Question: Which kind of chart has been used to present this data?
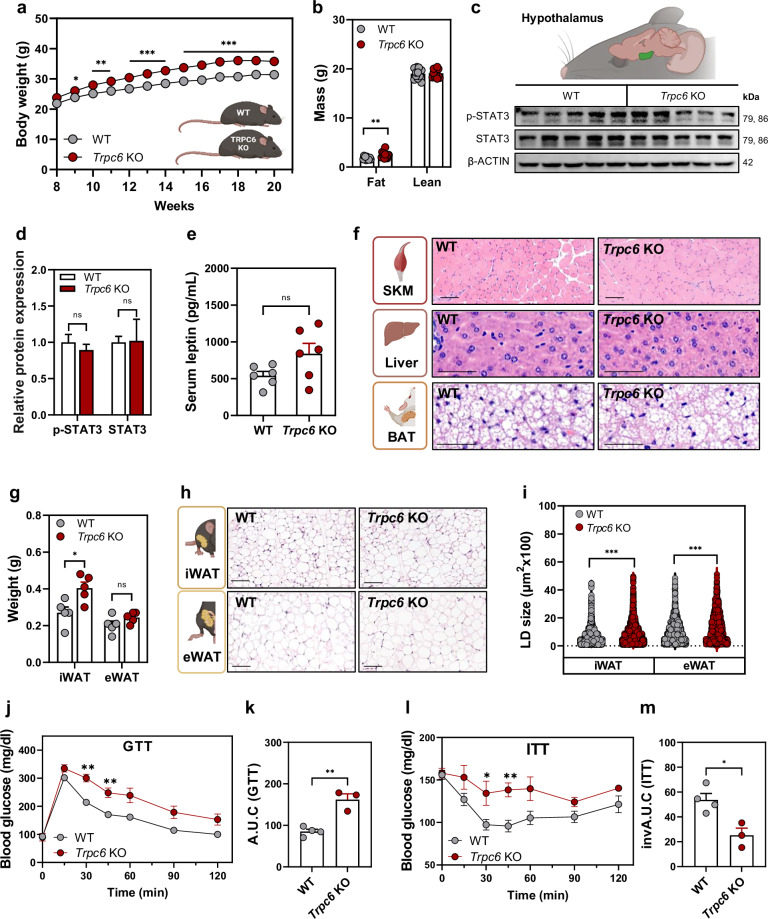
Answer: bar